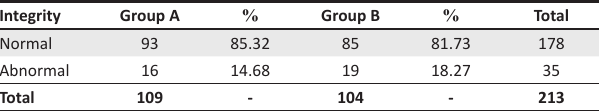
TABLE 6: Fundus auto fluorescence – retinal pigment epithelium integrity analysis.